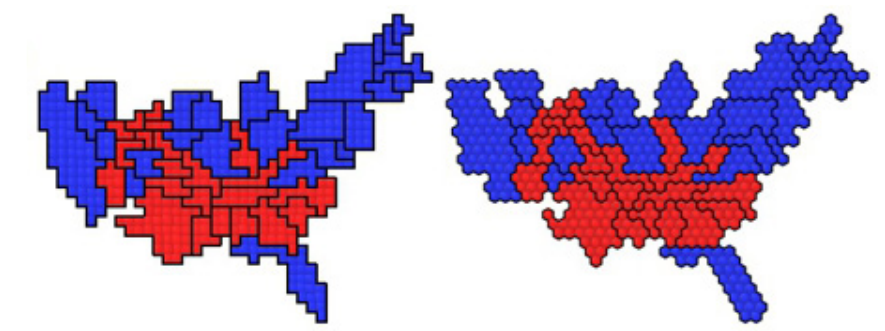
Fig. 4. Regular cartogram (squares or hexagons). Number of votes cast for candidates in the presidential election in 2012 (R.G. Cano et al. 2015)